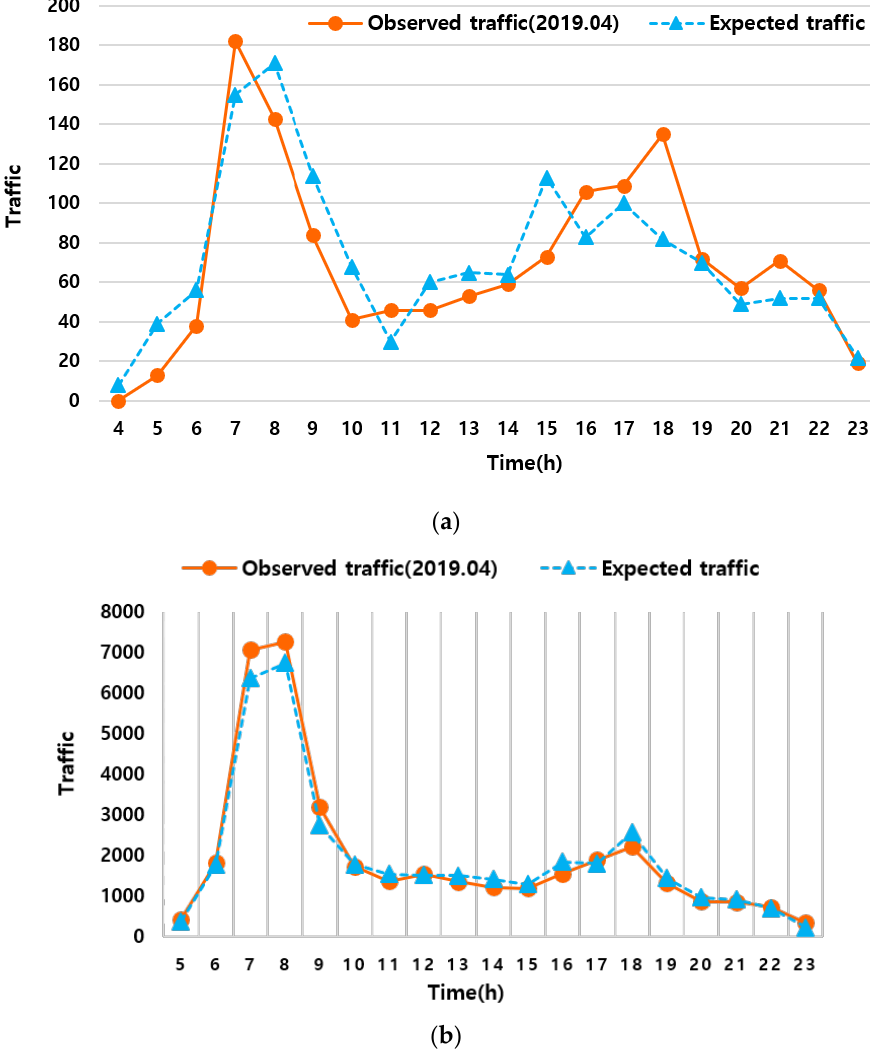
Figure 9. Average number of passengers per hour: ( a ) bus No. 1167; ( b ) Ui-Sinseol subway line.